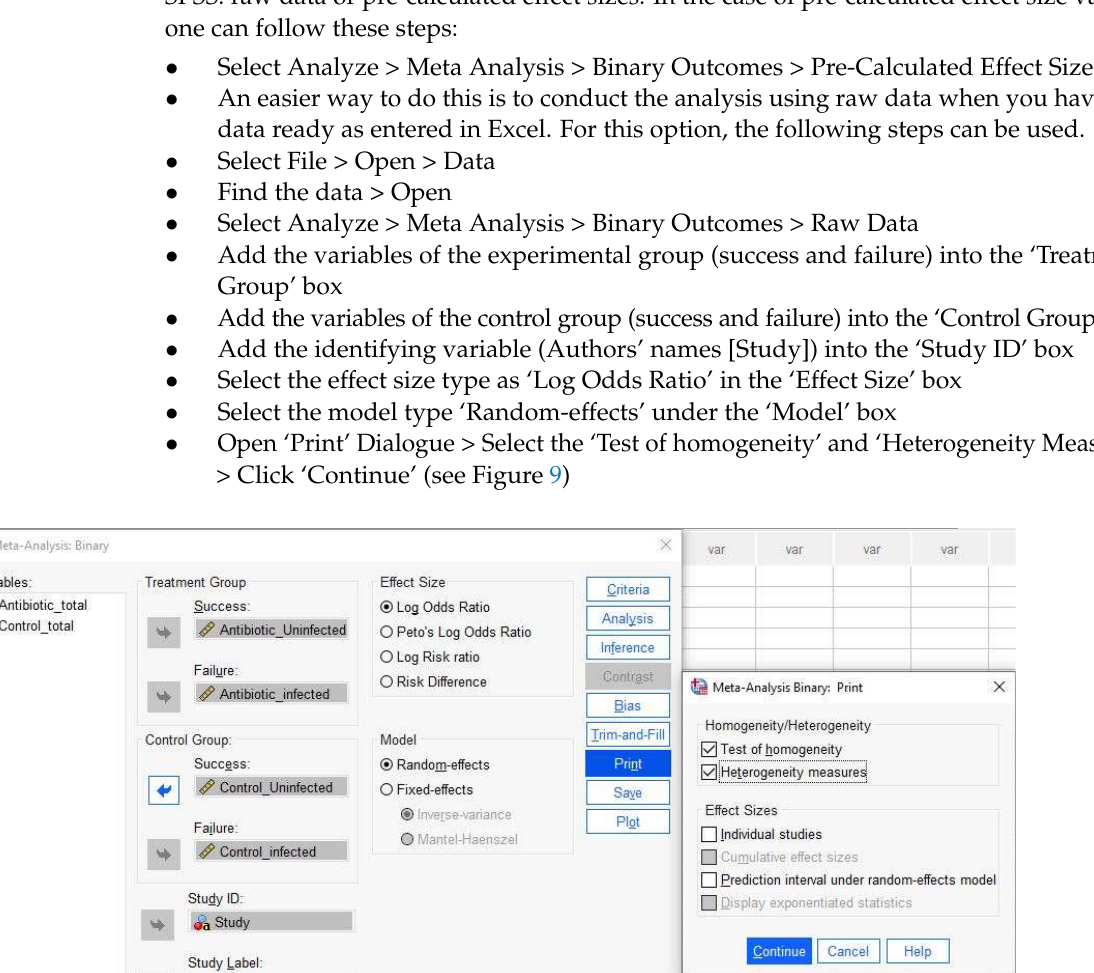
Figure 10. Forest Plot Menu. When these steps are applied, the outputs will be presented in the new window as in Figure 11.